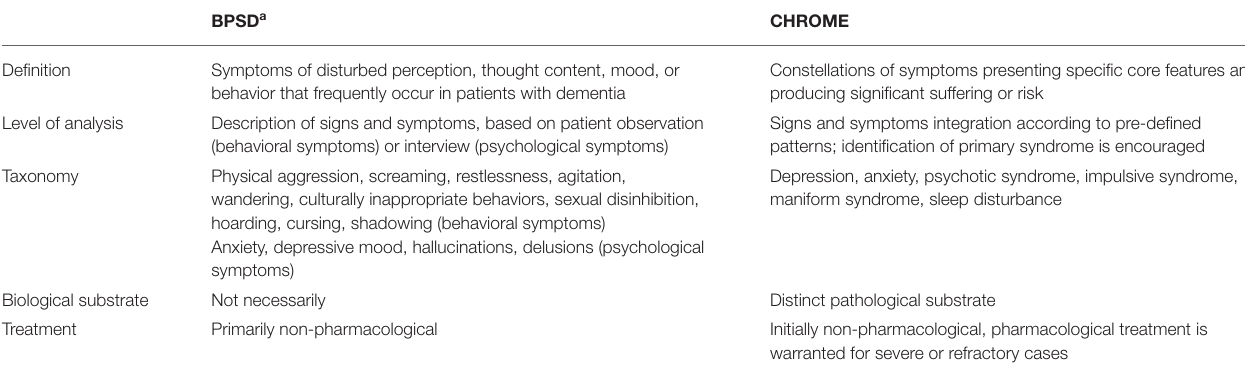
TABLE 1 | Differences between symptom (BPSD) and syndrome approach (CHROME) to the neuropsychiatric manifestations of dementia. BPSD